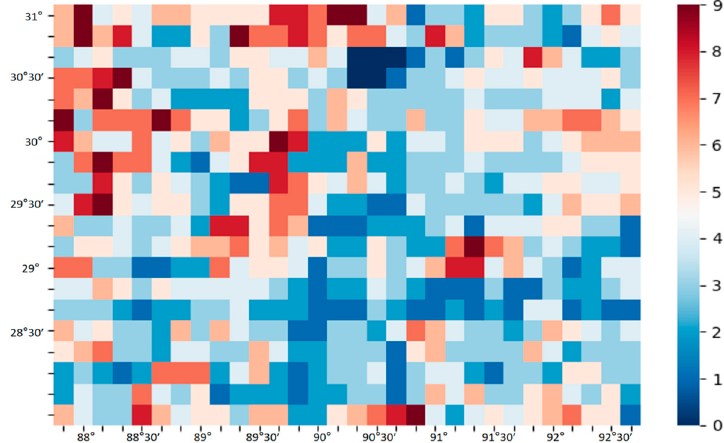
Figure 19. Heat map of multi-source geological information.